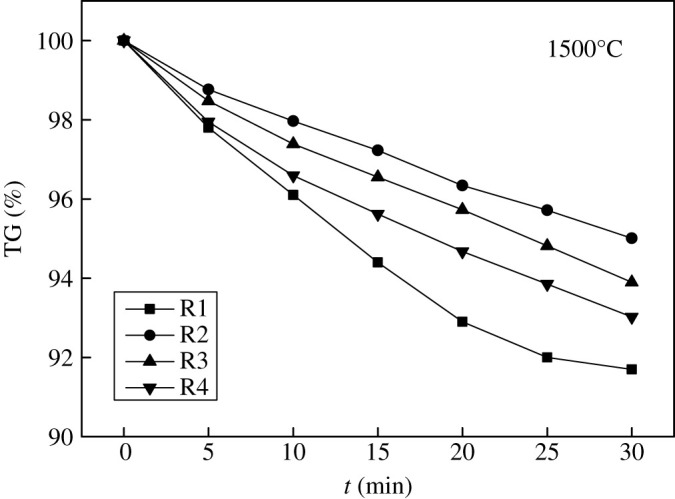
Effect of SiO2 on volatilization of refining slag. (R1: 40% CaF2–60% CaO; R2: 38% CaF2–57% CaO–5% SiO2; R3: 36% CaF2–54% CaO–10% SiO2; R4: 33% CaF2–50% CaO–17% SiO2).